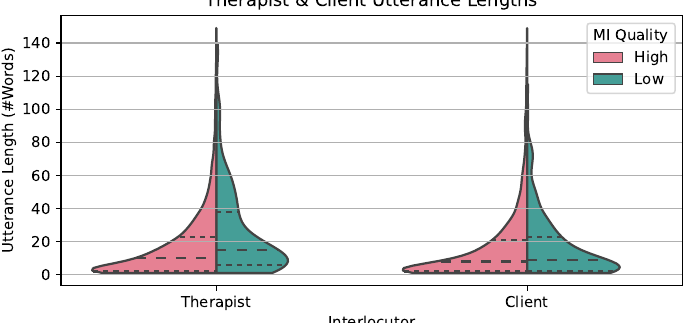
Figure 7. Lengths (number of words) of therapist and client utterances in high- and low-quality MI.